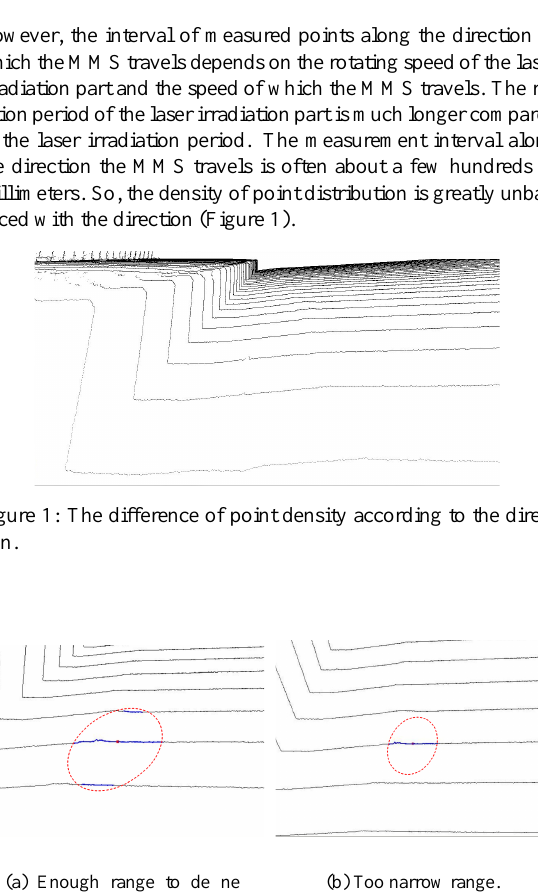
(b) Too narrow range.